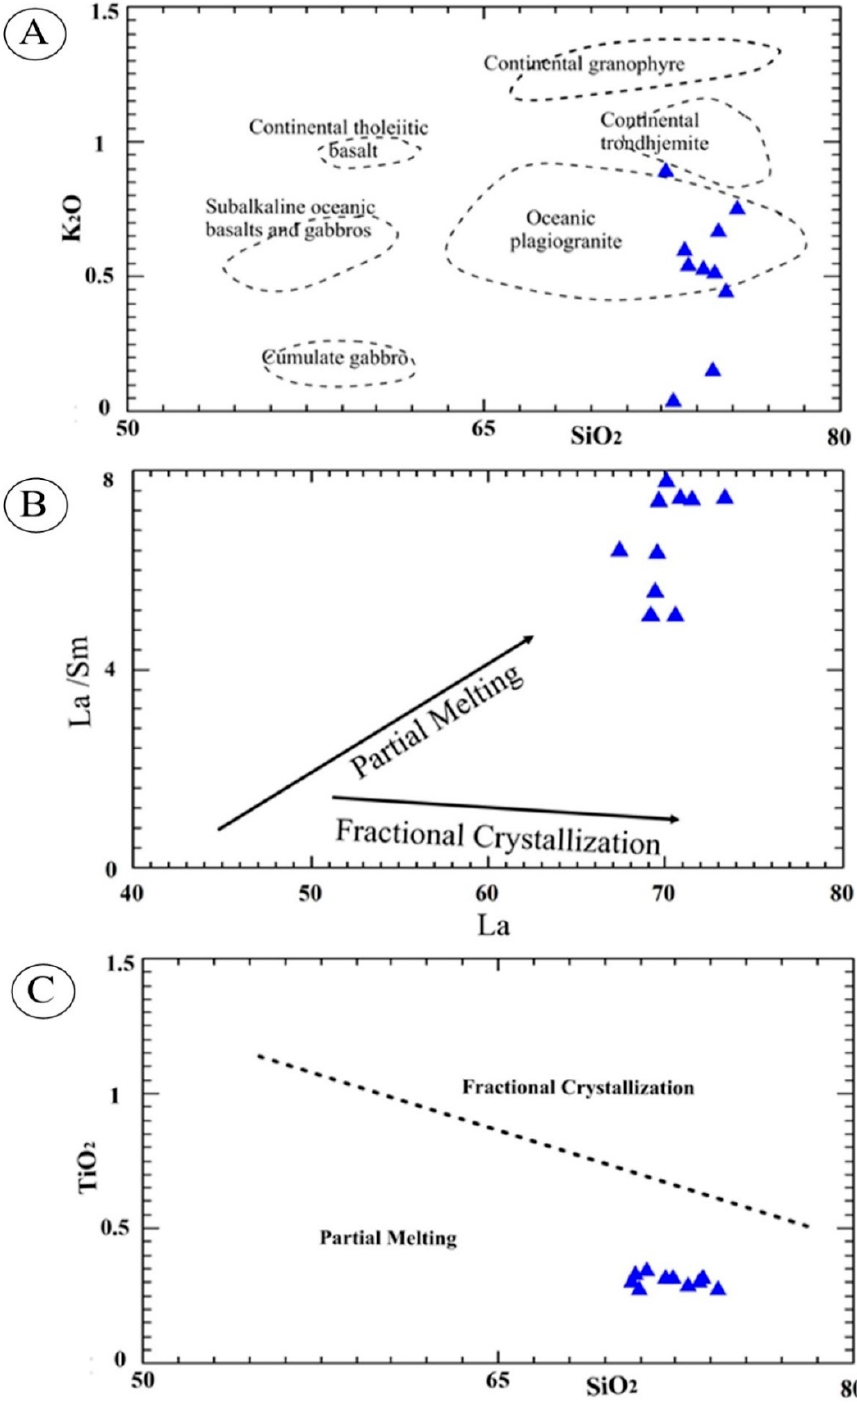
Figure 8. ( A ) Semi log plot of SiO 2 versus K 2 O [61] and location of the studied Abu Dabbab plagio-granite samples. ( B ) Plots of La versus La/Sm for the Abu Dabbab plagio-granites [62]. ( C ) SiO 2 versus TiO 2 [66].